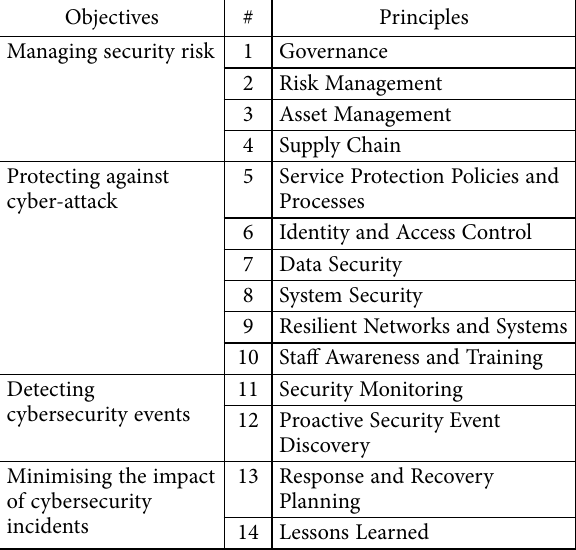
Table 1. List of principles in the cyber assessment framework from